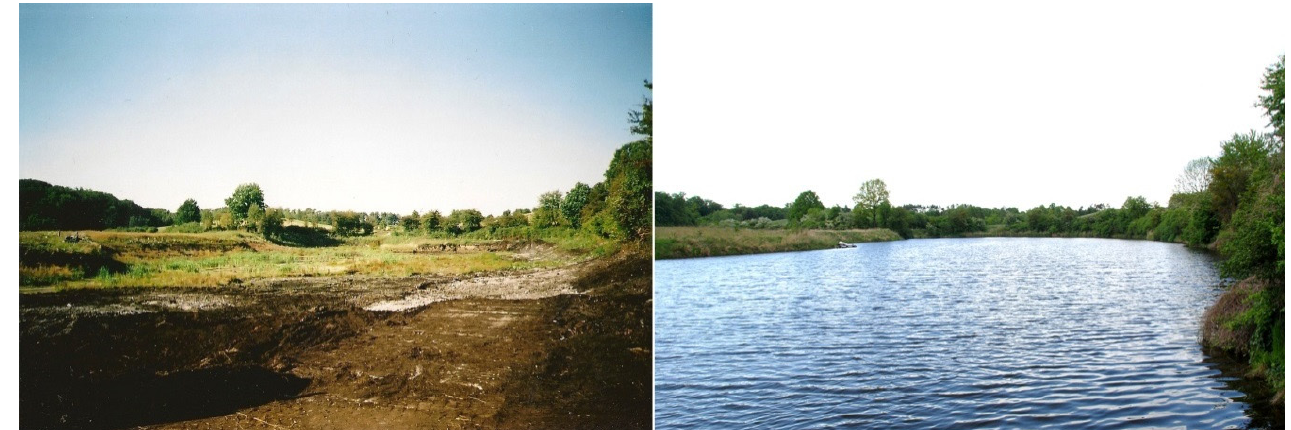
Figure 3. Part A of pit lake under construction ( left ) and one year after works ( right ). Table 2. Characteristics of the studied post-peat